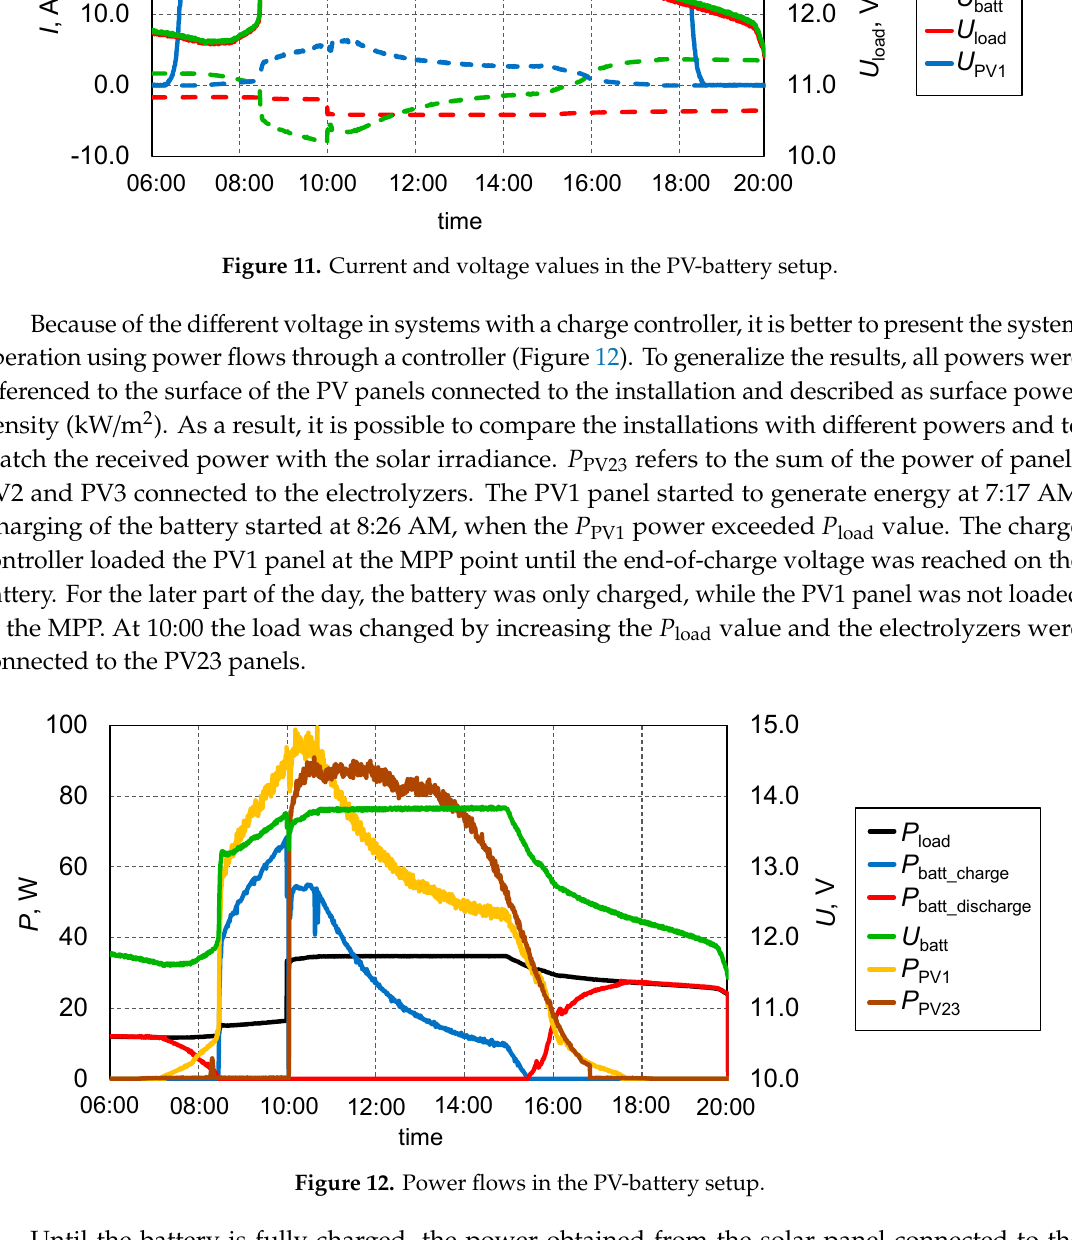
Figure 13. Power of 1 m 2 of PV panels in investigated setups as a function of irradiance. The P PV1 characteristics in the MPPT device operating range were nearly linear, but when the battery was fully charged, the panel was loaded beyond its maximum power point, as observed by a significant decrease in the power received from panel PV1. The characteristics of P PV23 were non- linear, and a significantly lower power was achieved compared to PV1 at higher irradiance values. This was important because most of the energy from the photovoltaic panels was obtained for irradiance above 500 W/m 2 . In this range of irradiance the panel temperature usually increases and the operating point of the panel and the electrolyzer move away from the MPP, which is shown in Figure 10. The efficiency of PV23 was higher than PV1 (Table 1); therefore, the characteristics of PV23